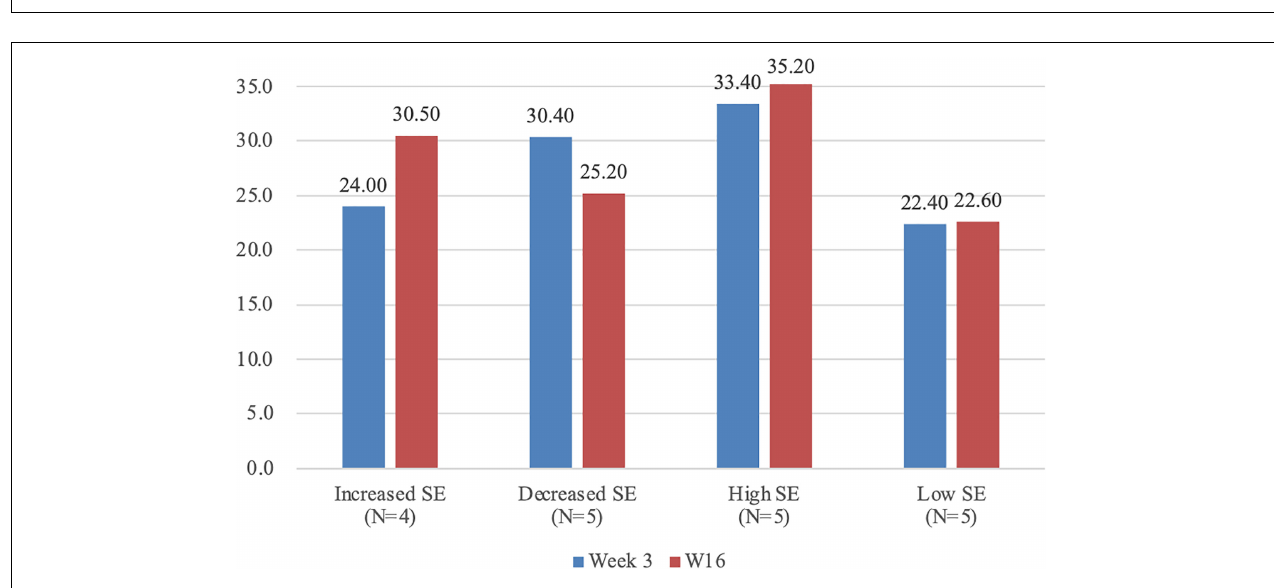
FIGURE 4 | Changes of students’ SE for online SRL throughout the semester.